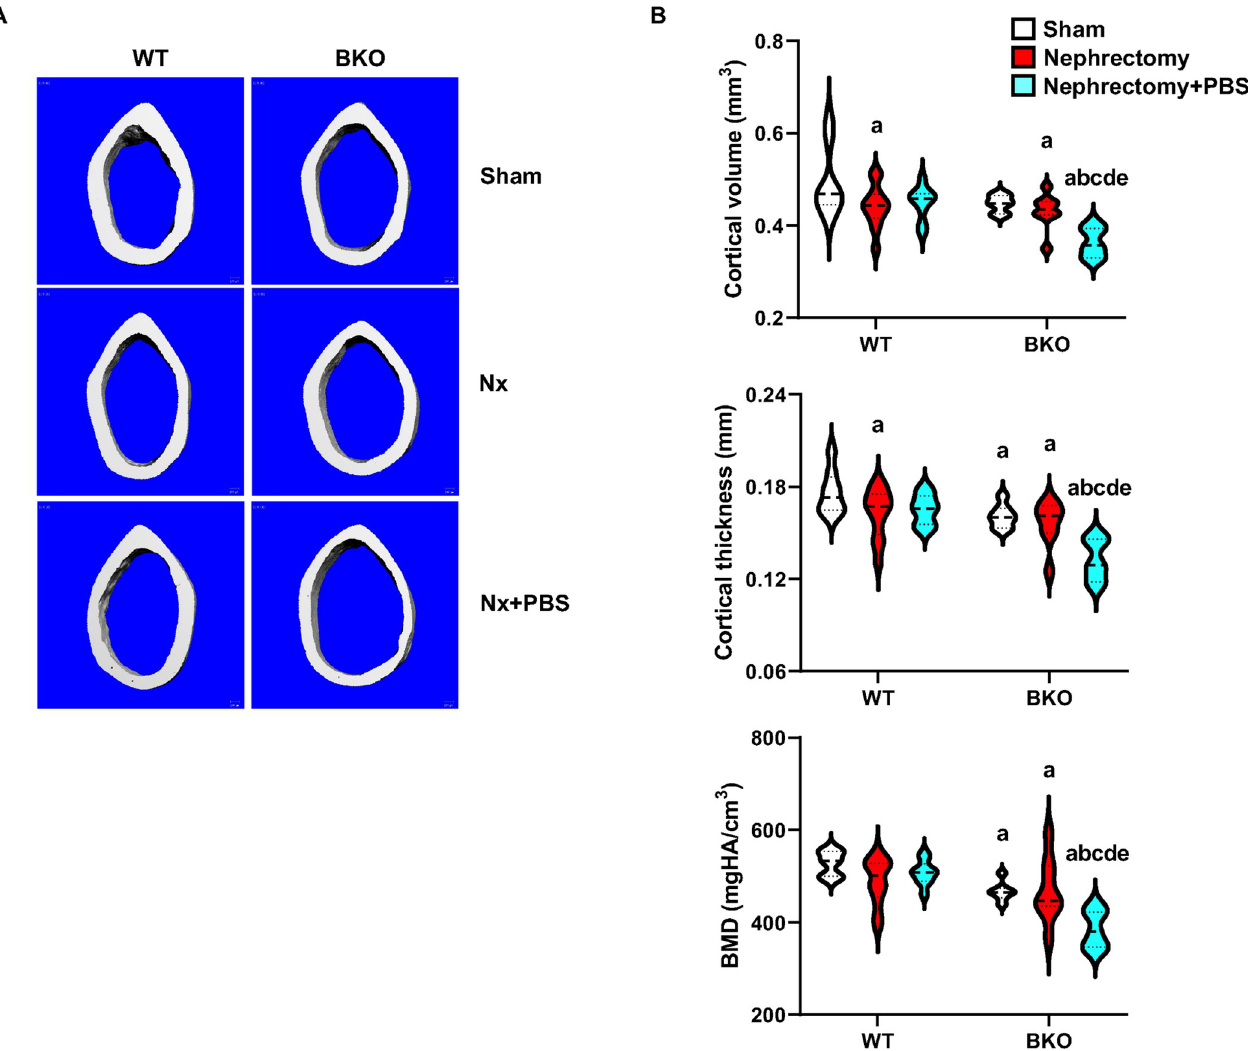
Fig 4. High phosphate increases cortical bone loss in nephrectomized BKO mice. (A) Representative μ CT images of cortical bone. (B) μ CT analysis of cortical bone as violin plots. a p < 0.05 versus sham WT, b p < 0.05 versus nephrectomized WT, c p < 0.05 versus nephrectomized WT+PBS, d p < 0.05 versus sham BKO, and e p < 0.05 versus nephrectomized